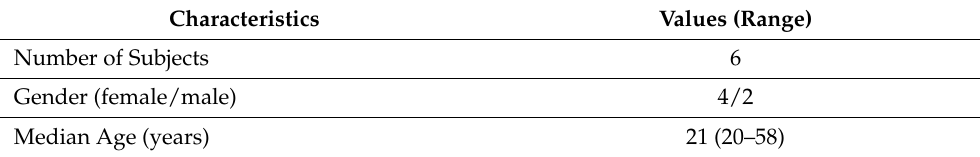
Table 1. Characteristics of the study